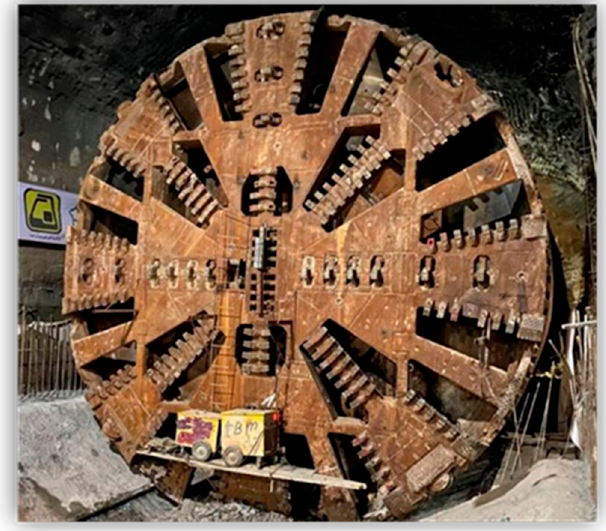
Figure 2. Successful and accurate arrival of the TBM (EPB shield) to the A6-4 Station .